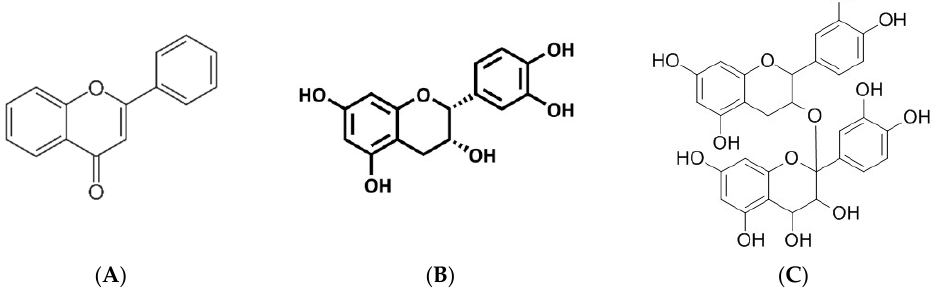
Figure 7. An overview of the chemical structure of flavonoids ( A ), flavanols ( B ), and proanthocyanidins ( C ). Briefly these polyphenols are commonly found in in plants and food sources such as wine, tea and chocolate [69,70].